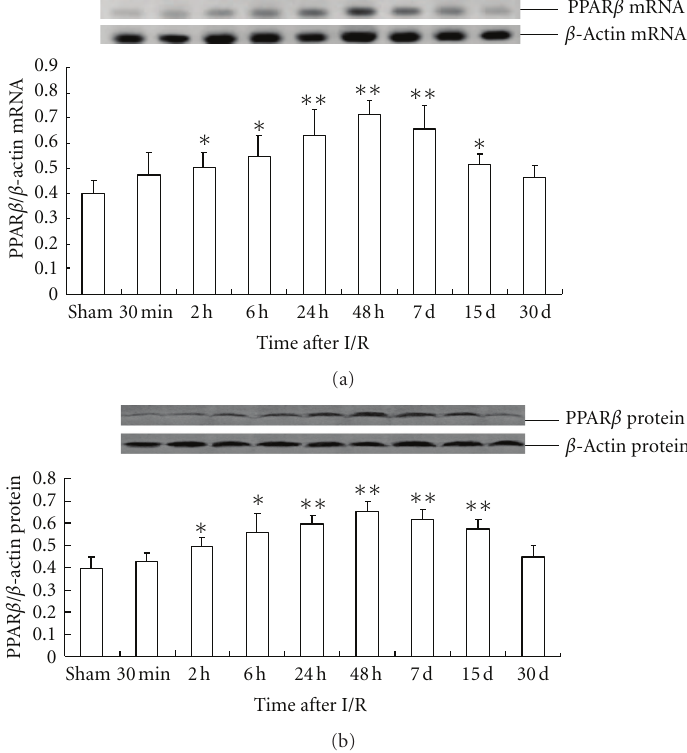
Figure 5: Time-dependent expression of PPAR β in global cerebral I/R rat hippocampus ( n = 4). (a) The relative mRNA level of PPAR β was normalized to endogenous β -actin mRNA for each sample. (b) The relative protein level of PPAR β was normalized to endogenous β - actin protein for each sample. Dates are expressed as mean ± SD of four individual experiments. ∗∗ P < 0 . 01 compared with sham group; ∗ P < 0 . 05 compared with sham